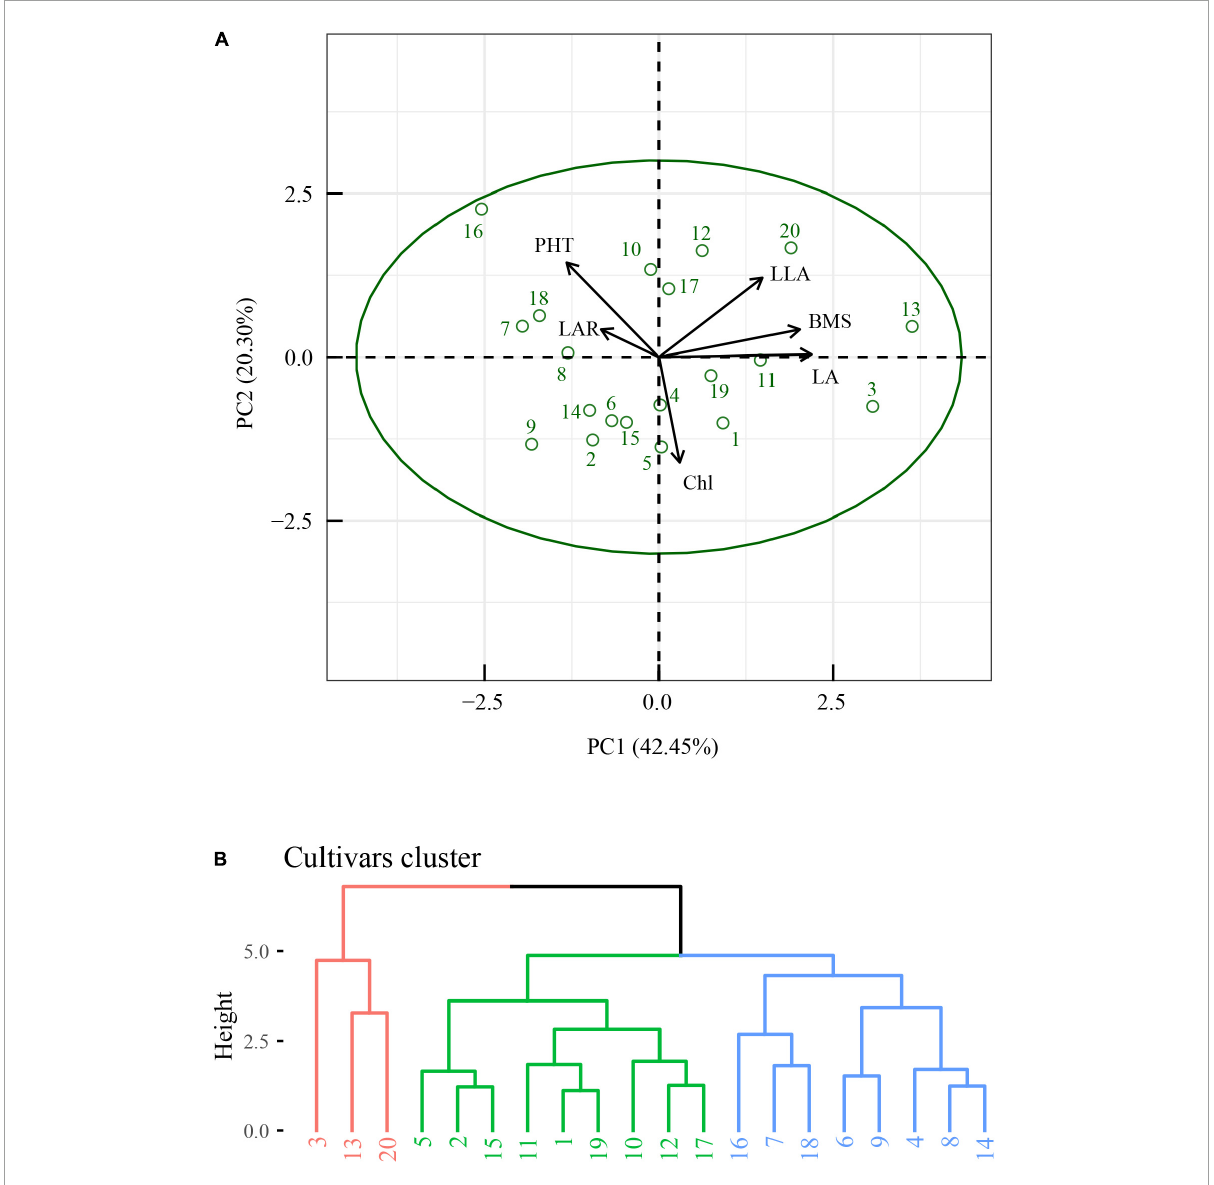
FIGURE6 Principal component analysis (PCA) of the plasticity of biomass and the plasticity of top five most important explanatory variables (A) , and clustering analysis of the soybean cultivars (B) . BMS, biomass; LA, leaf area; LAR, leaf area ratio; LLA, leaflet area; PHT, plant height; Chl, Chl content. The numbers in panel (B) represent